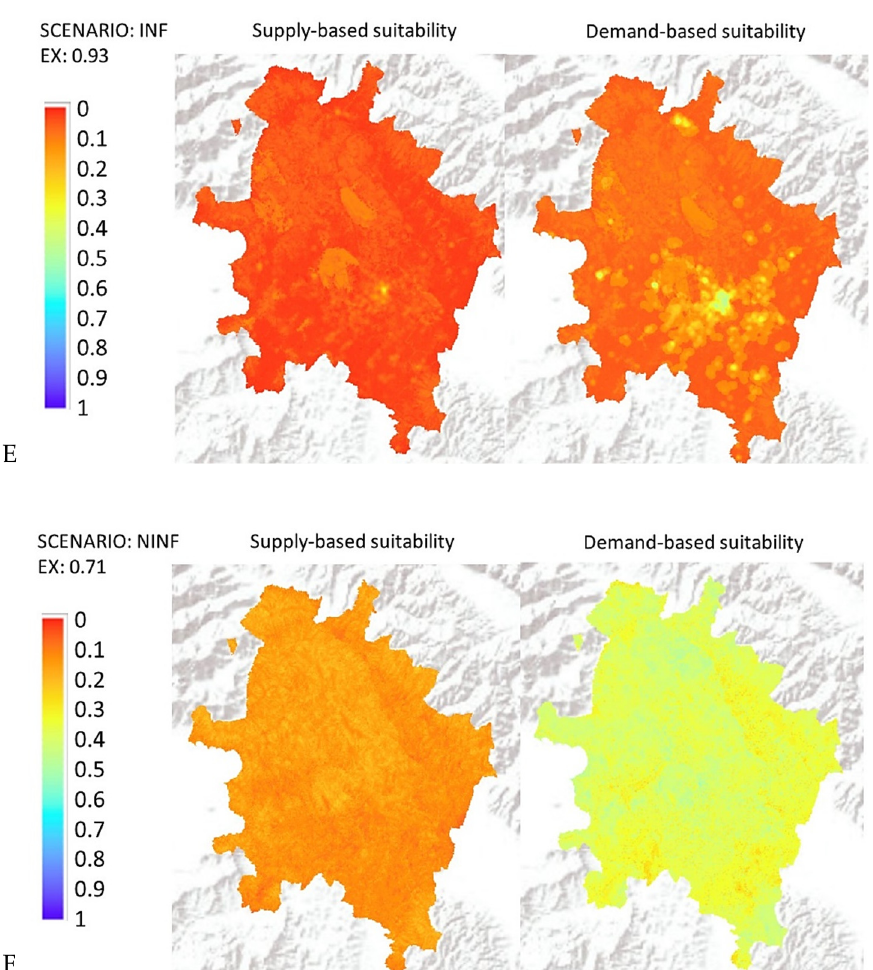
Figure 4. Maps from SUSAM application in the different scenarios. ( A ): BASE, ( B ): FARM, ( C ): HOUS, ( D ): COMM, ( E ): INF, ( F ): NINF, EX: explained suitability (scenario codes are described in Table 2).